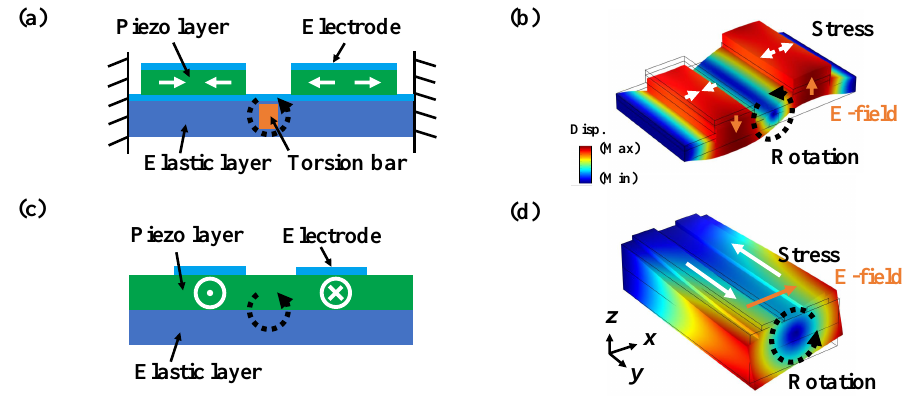
Figure 1. ( a ) Section view of the e 31 torsional actuator; ( b ) 3D deformation of the e 31 torsional actuator; ( c ) Section view of the e 16 torsional actuator; ( d ) 3D deformation of the e 16 torsional actuator. The white arrows, orange arrows and black dashed arrows in this figure represent the stress, electric field and rotation direction,